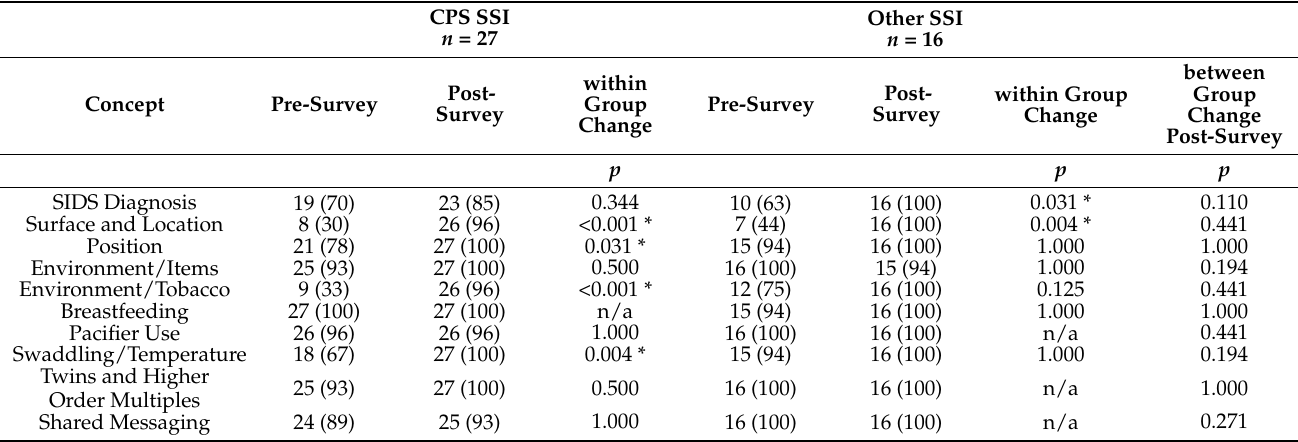
Table 1. Safe Sleep Instructor (SSI) trainees reporting only safe/correct responses for knowledge of American Academy of Pediatrics safe sleep